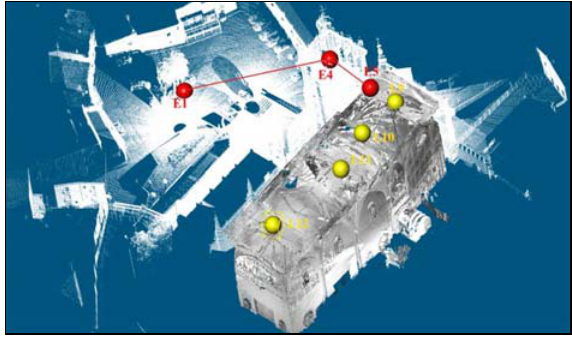
Figure 7. Scanning and station